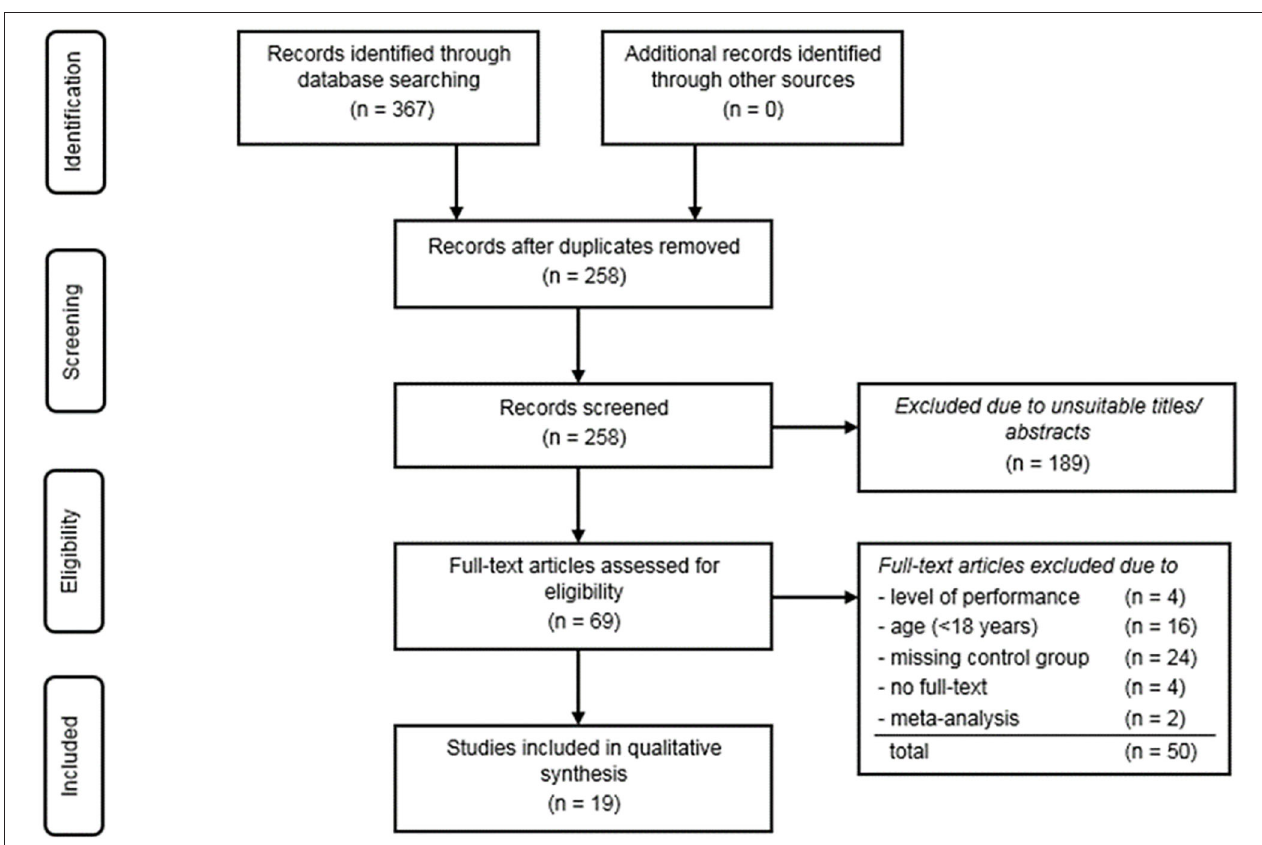
FIGURE 1 | Flow chart of the study selection